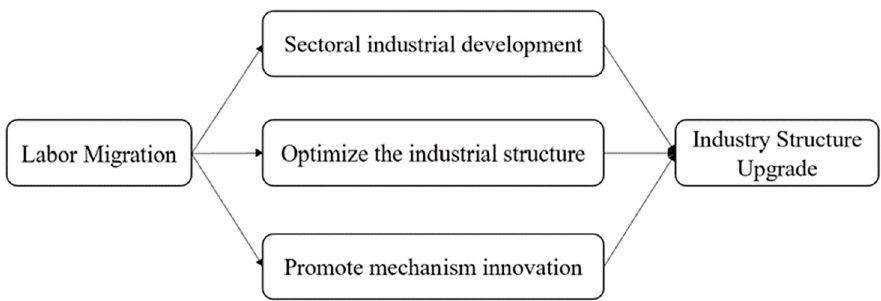
Figure 2. Possible paths of labor migration on the forestry industry structure upgrading.